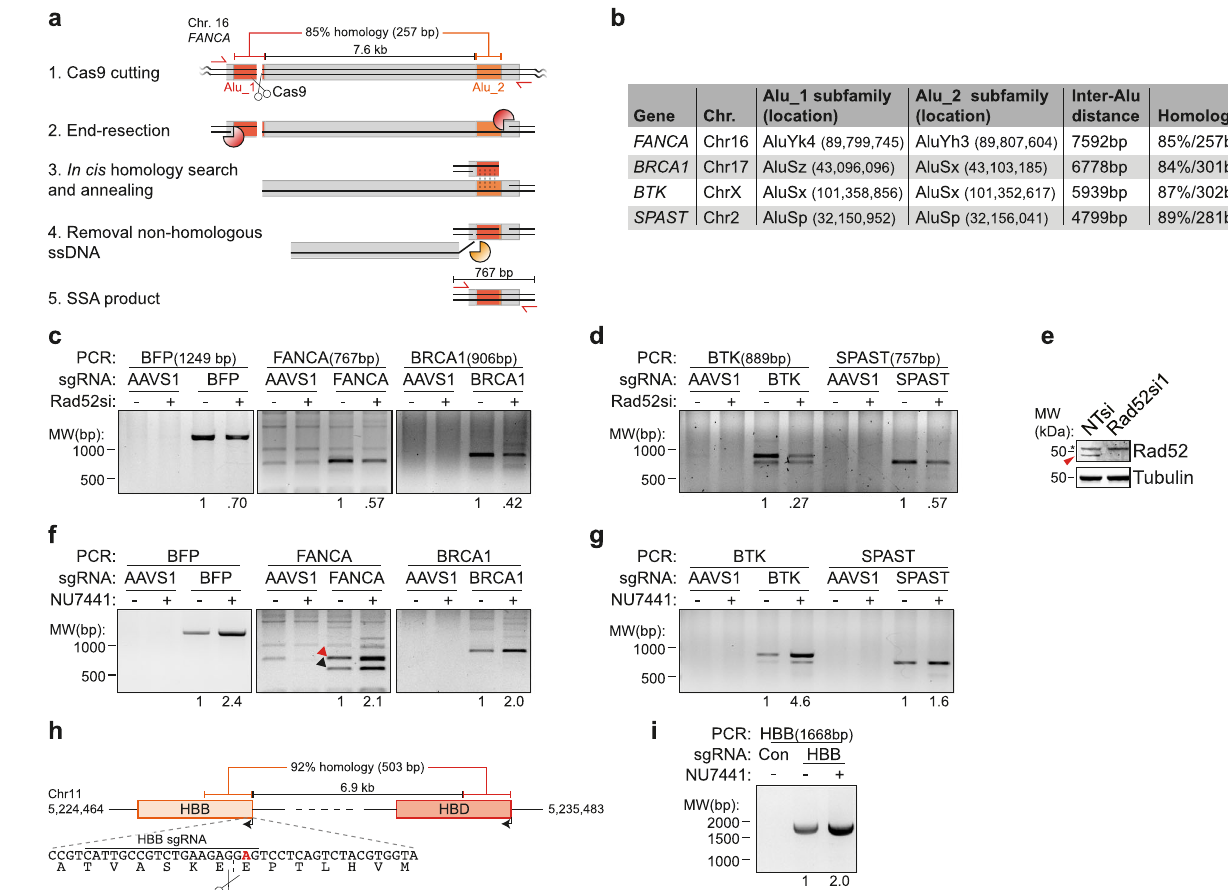
Fig. 5 | SSA contributes to repair of DSBs in endogenous genomic loci. a Schematic representation of SSA repair of a Cas9-induced DSB at the Alu_1 target site in the FANCA gene. Indicated are the primers (in red) to amplify the SSA repair product, and the nucleases that perform end-resection (orange pacman) or ssDNA fl ap removal (yellow pacman). b Table indicating the sub- family, chromosomal location, and level of sequence homology of the Alu elementsthatcouldannealduringSSArepairoftheDSBattheAlu_1targetloci. c, d HEK 293T DSB-Spectrum_V2 cells ( c ) or regular HEK 293T cells ( d ) were transfected with a nontargeting control siRNA ( “ - ” lanes) or Rad52-targeting siRNA, then retransfected with the indicated Cas9-sgRNA constructs. Genomic DNA was isolated and SSA DSB-repair products PCR ampli fi ed. Representative gel images are shown ( n = 2). Expected size of the SSA repair product and the quanti fi ed SSA band intensities are shown at the top and the bottom of the image, respectively. e Western blot of lysates from panels c and d . Red arrow